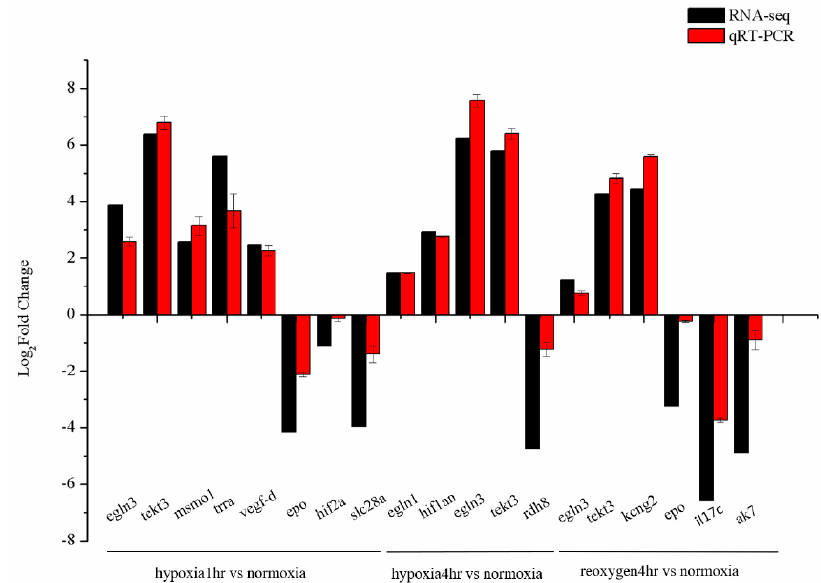
Figure 3. Comparison of gene expression data between RNA-seq and quantitative real-time PCR (qRT-PCR). The x -axis presents the gene name and the y -axis presents fold change in gene expression.